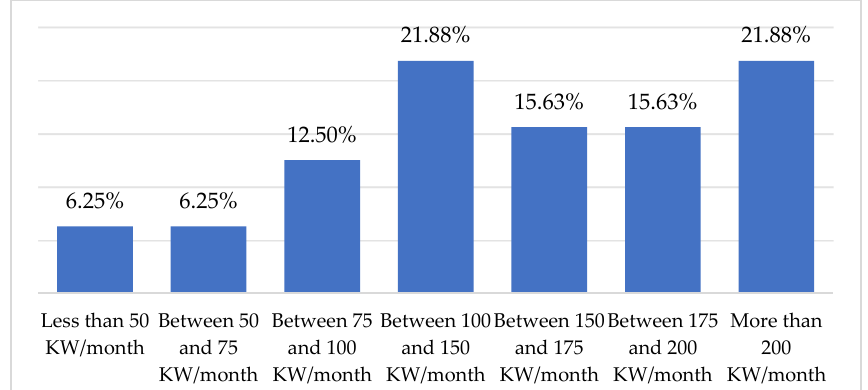
Figure 6. Average energy consumption (kW) in the Residential complex [22].